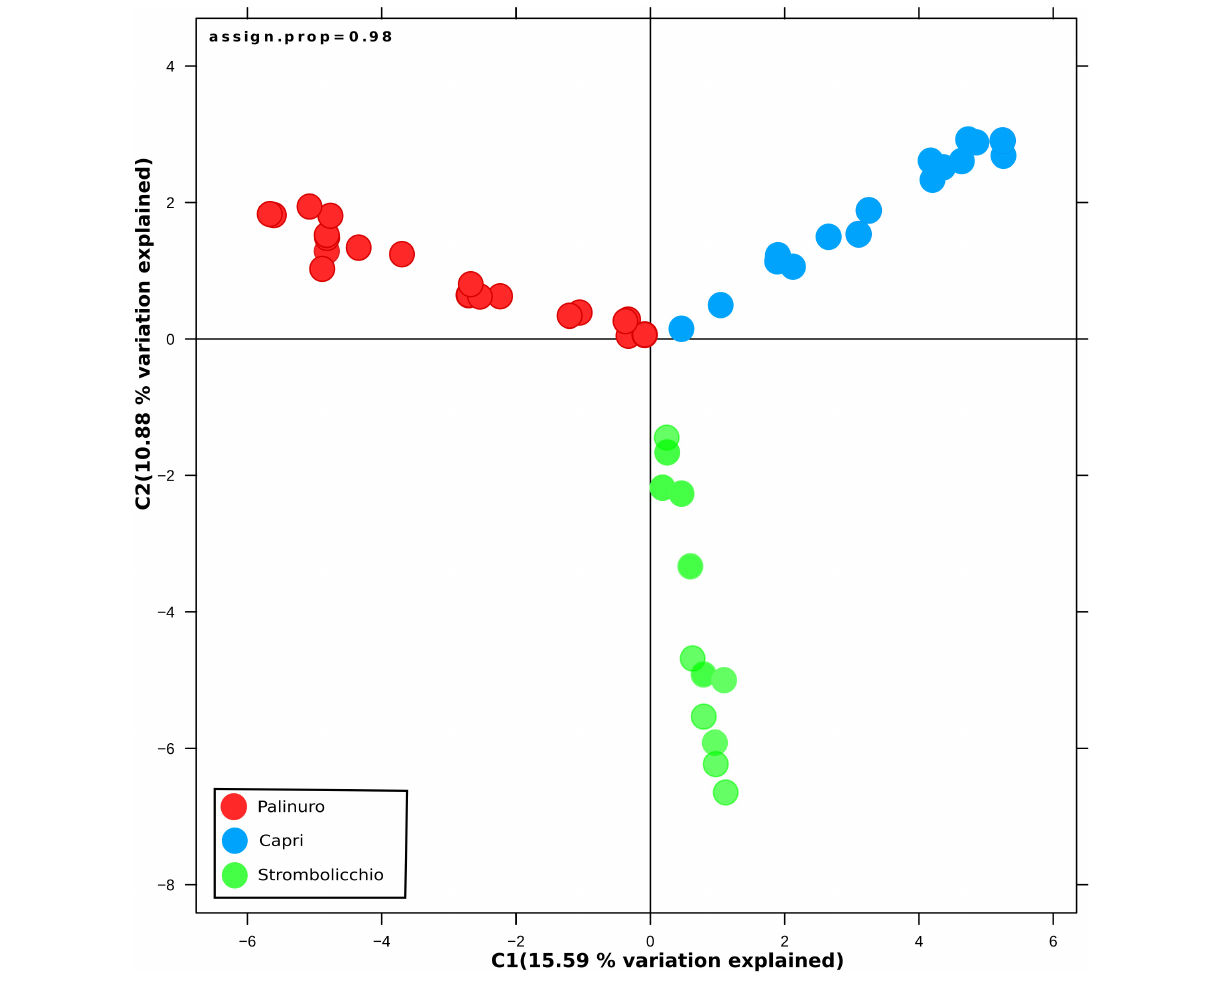
FIGURE 3 | Discriminate analysis of principal components (DAPC). The analysis was drawn using 3,962 SNPs across 48 individuals (SNPs present in at least 70% individuals) and was constructed using 20 principal components (PCs) and two discriminate functions. Dots represent individuals, with colors denoting sampling